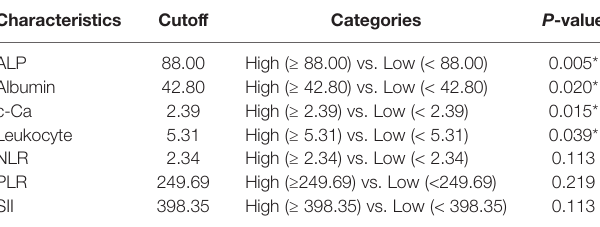
TABLE 2 | Cutoff value and univariate Cox analysis of hematology markers in the internal set. Characteristics